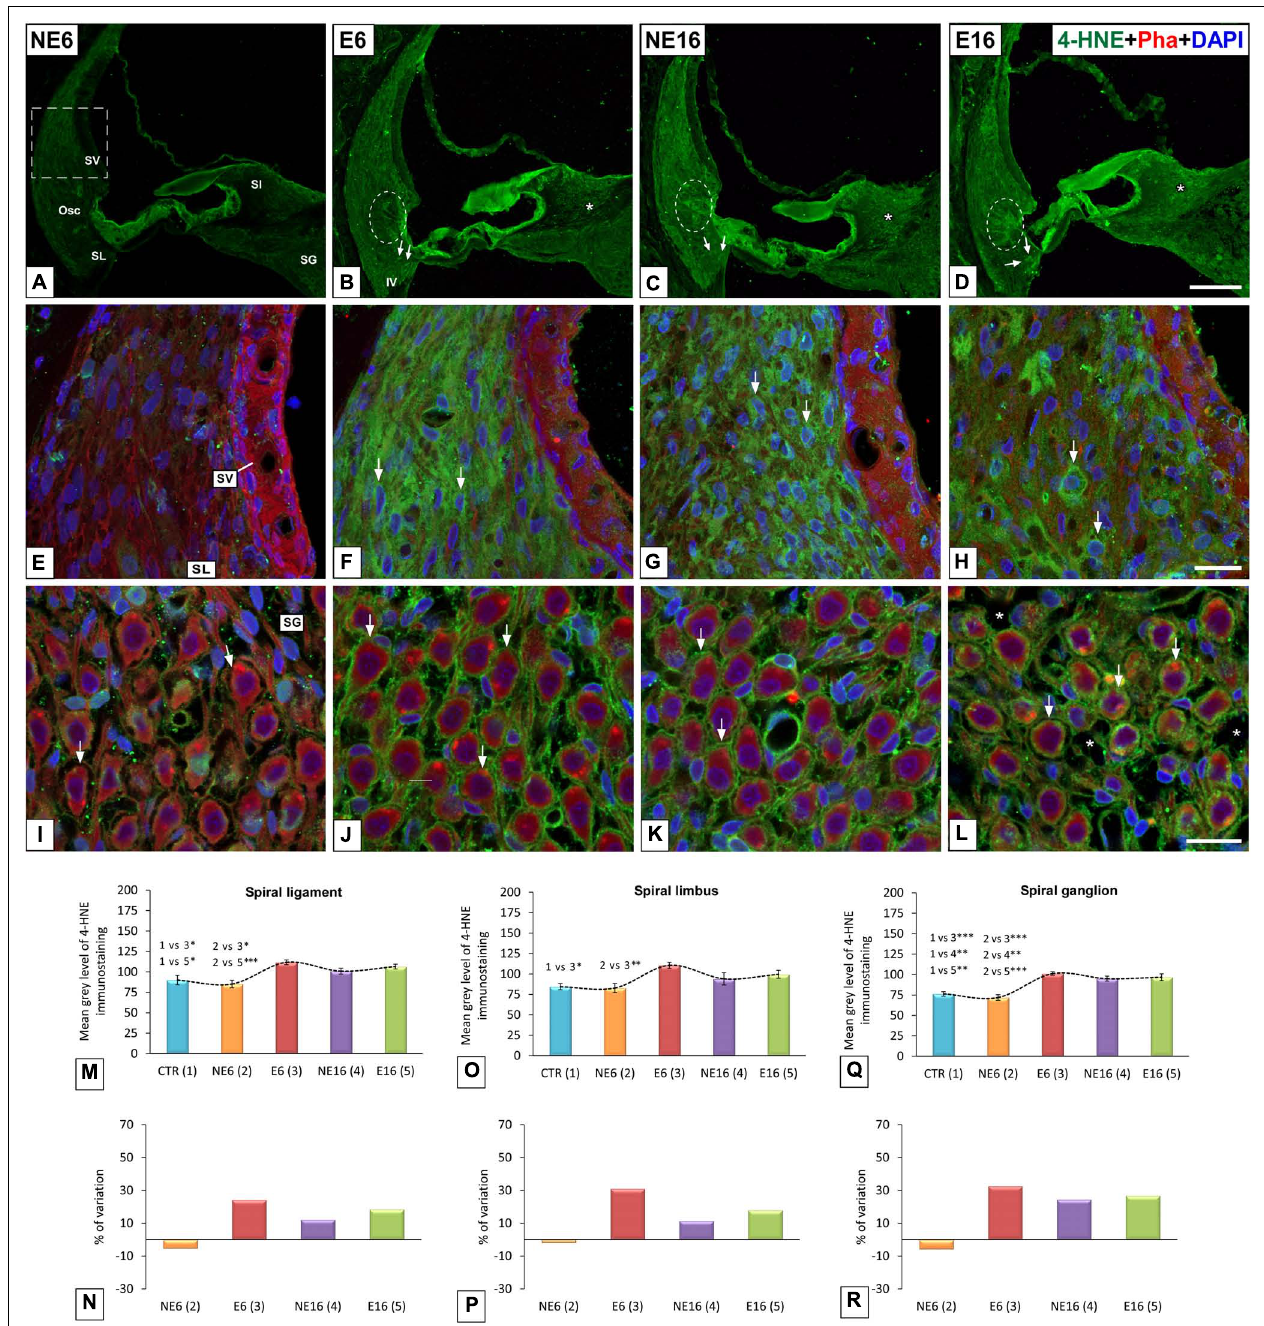
FIGURE 6 | Digital images showing 4-HNE-immunostaining in young/adult and aging cochleae exposed to NAP. (A–D) Cochlear midmodiolar sections showing increases in 4-HNE-immunostaining (green) in the spiral ligament, spiral limbus, organ of Corti, and spiral ganglion in E6 (B,F,J) , NE16 (C,G,K), and E16 (D,H,L) rats compared to unexposed (A,E,I) control rats. The quantification of immunostaining and percentage of variation for each cochlear structure of interest in each group corroborated these increases (M–R) . The dashed square box in (A) represents the approximate location of the higher-magnification images shown for each group. Dashed ovals in (B–D) encircle outer sulcus root cells. Arrows point to 4-HNE-stained cells, and asterisks in L indicate blood vessel dilation. Phalloidin (red) was used to label staining actin filaments and cell nuclei (blue) were counterstained with DAPI.Osc, outer sulcus; SL, spiral ligament; SG, spiral ganglion; Sl, spiral limbus; SV, stria vascularis. ∗ p < 0.05; ∗∗ p < 0.01; ∗∗∗ p < 0.001. Scales bars: 100 µ m in (D) ; 20 µ m in (H,L) . n = 4 for each animal group.